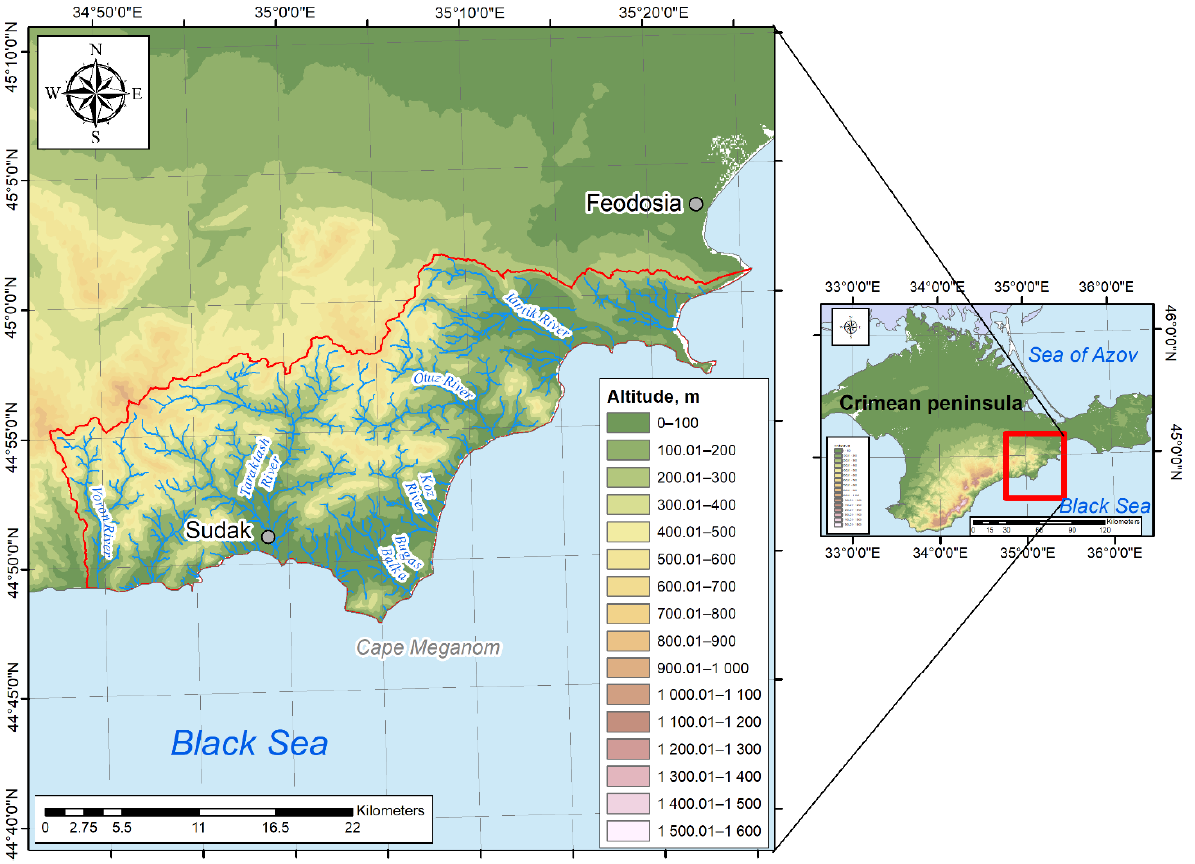
Figure 1. Territory of Southeastern